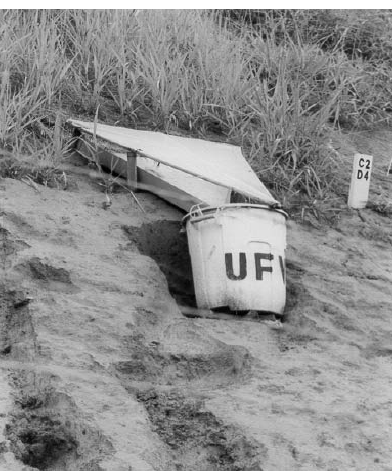
Figura 2. Sistema coletor da suspensão de água + solo